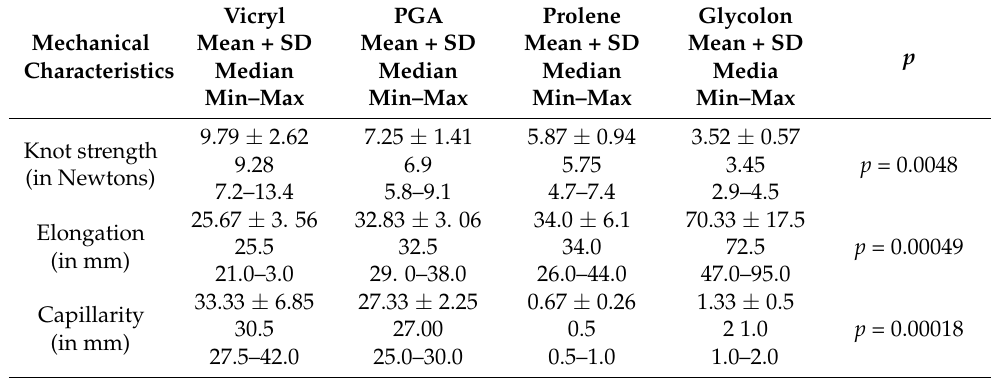
Mechanical Table 2. Results of the study of suture materials mechanical properties.